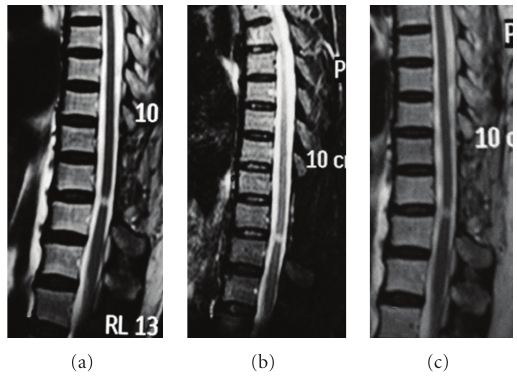
Figure 8: A 67-year-old female su ff ered from progressive parapare- sis and paresthesias for 1 month. There is a small demyelinating lesion at the level between T9 and T10. Steroid pulsed treatment worsened her condition. After ATT, her weakness quickly improved.